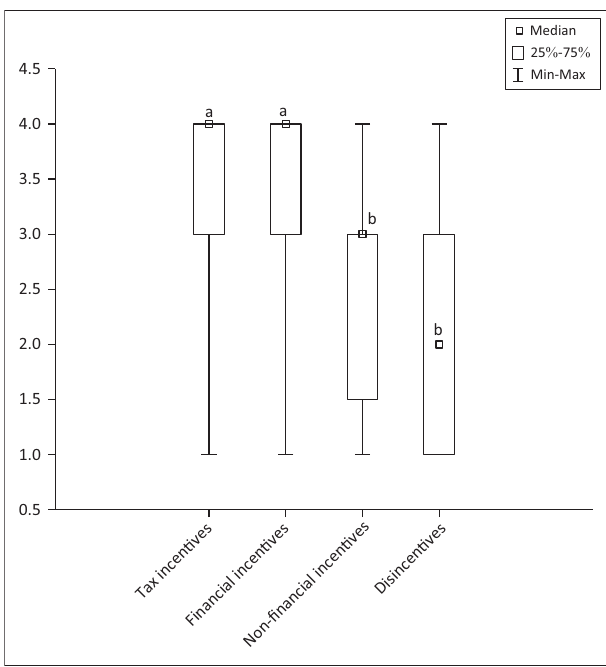
FIGURE 2: Statistical comparison of government measures, indicating